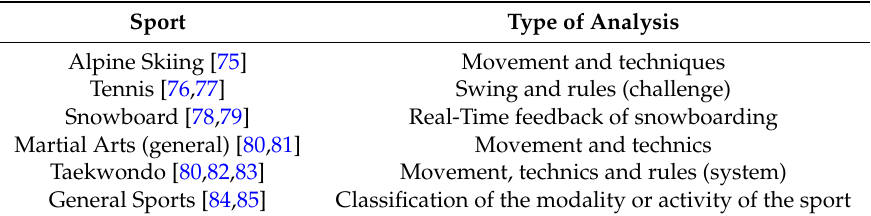
Table 1. General applications for sensor fusion and smart sensor on sports.